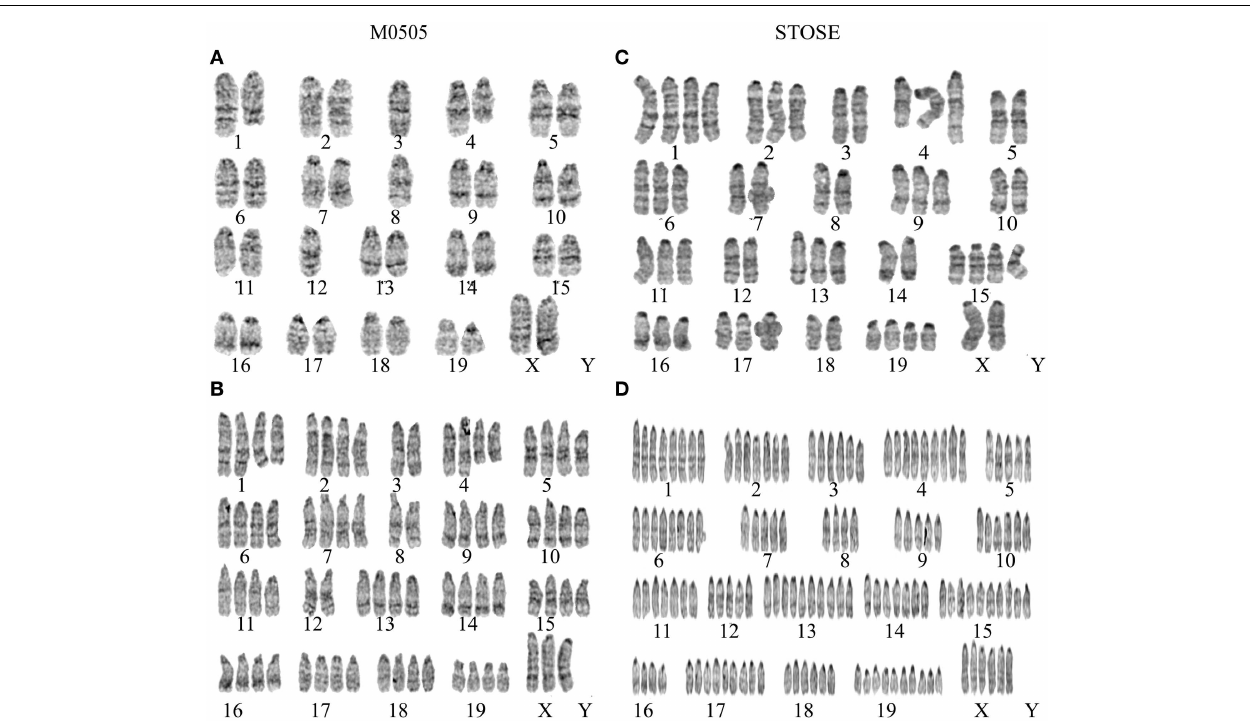
loss of a chromosome 3, 8, and 12 was evident in all M0505 cells analyzed. (C) Near-triploid STOSE cell with 54 chromosomes. (D) Polyploid STOSE cell with 143 chromosomes. (C,D) An addition at the terminal end of chromosome 4 as well as a loss of chromosome 3, 5, and 8 were evident in all STOSE cells